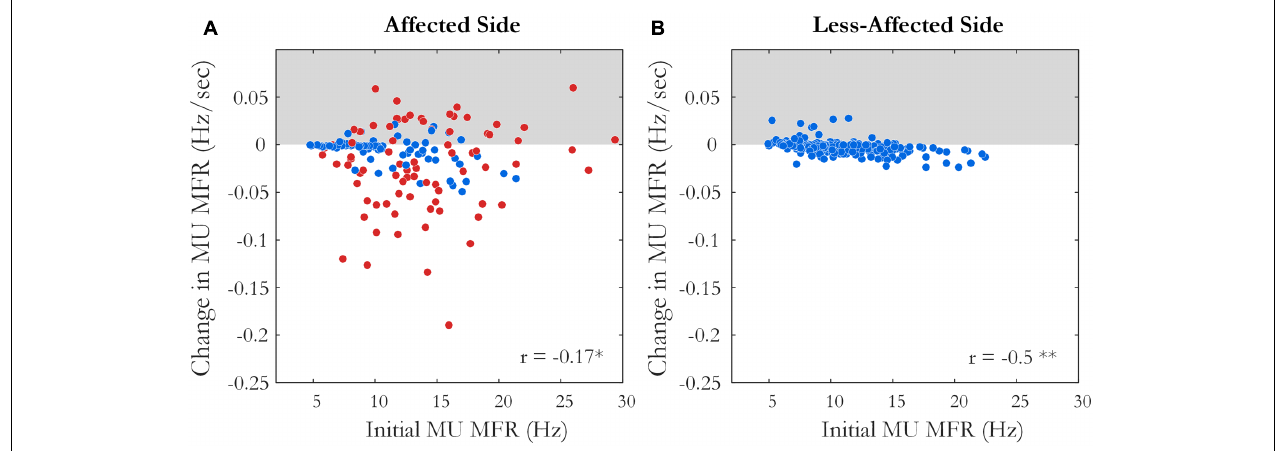
FIGURE 7 | The slope and intercept of the linear fit to the change in MU MFR over the course of the sustained fatiguing contraction over all subjects on (A) the affected side, ∗ p < 0.05 and (B) the less-affected side, ∗∗ p < 0.01. Each data point represents an accepted MU; red points indicate MUs from the affected side of subjects with an endurance time for the fatigue task < 75% of the shortest time to task failure on the less-affected